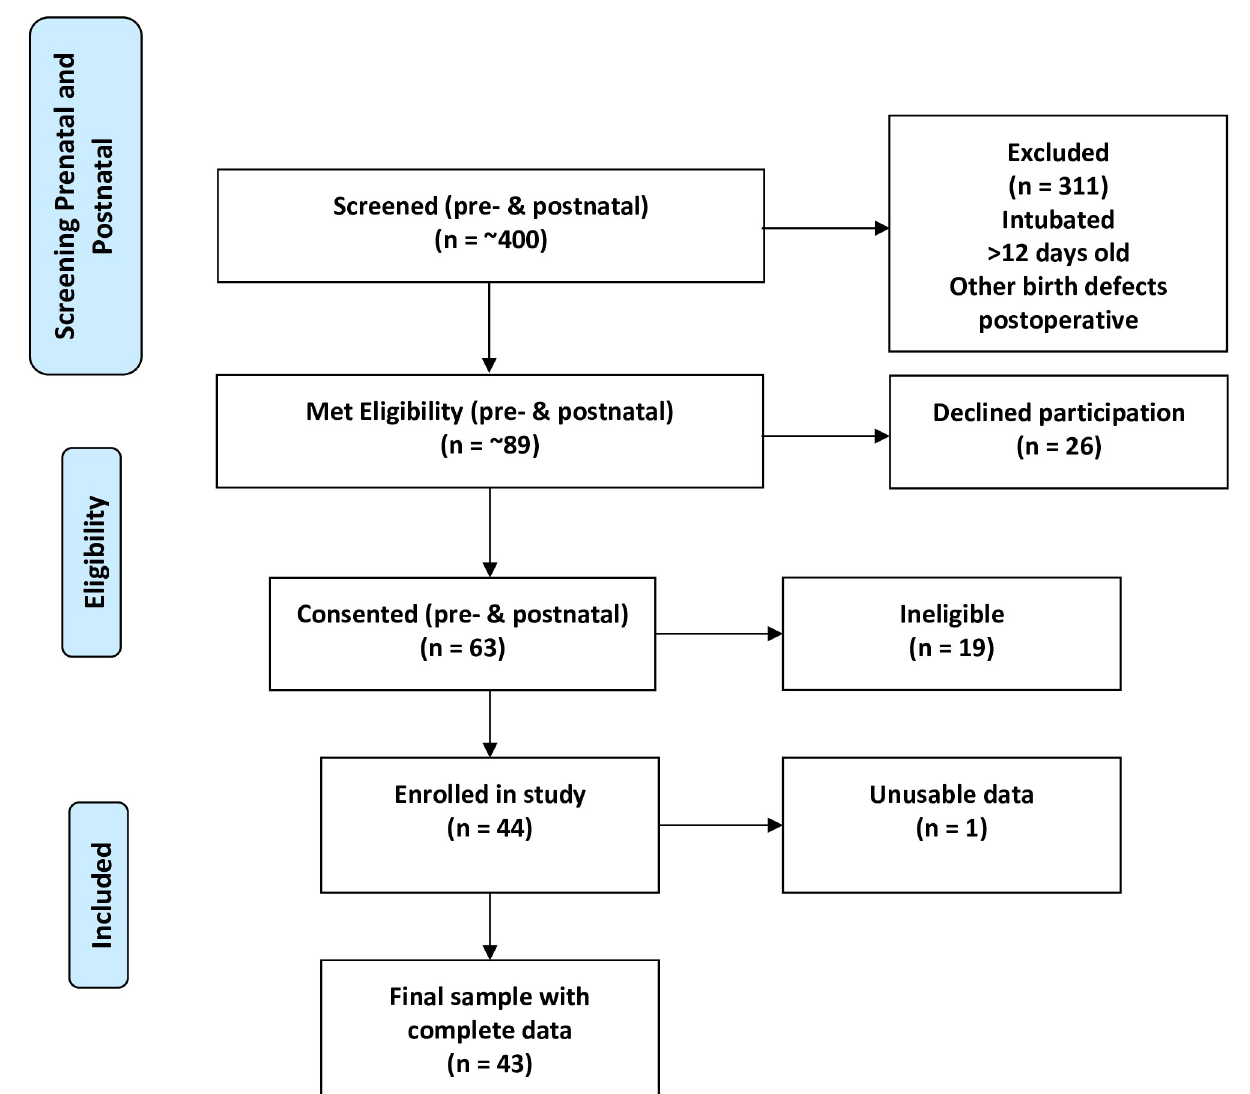
Fig 2. Eligibility flow